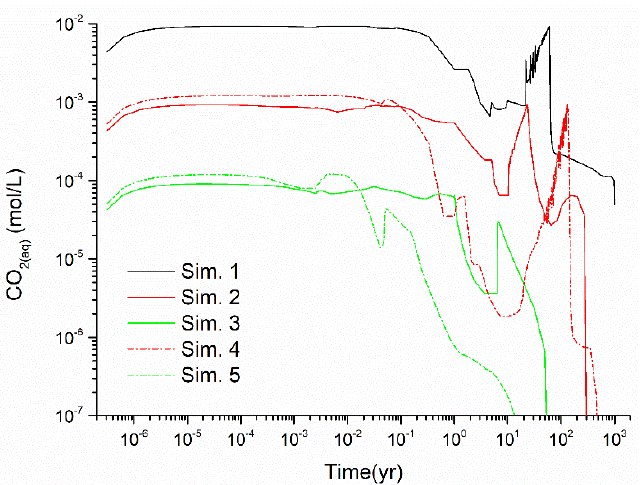
Figure 7. Simulations 1–5: (1) CO 2(aq) evolution (mol/L) over time at 165 ◦ C and PCO 2 = 1.2 bar (Sim. 1, black line), (2) PCO 2 = 0.12 bar (Sim. 2, red line), (3) PCO 2 = 0.012 bar (Sim. 3, green line), (4) at 85 ◦ C and PCO 2 = 0.12 bar (Sim. 4, red dot line) and (5) PCO 2 = 0.012 bar (Sim. 5, green dot line).